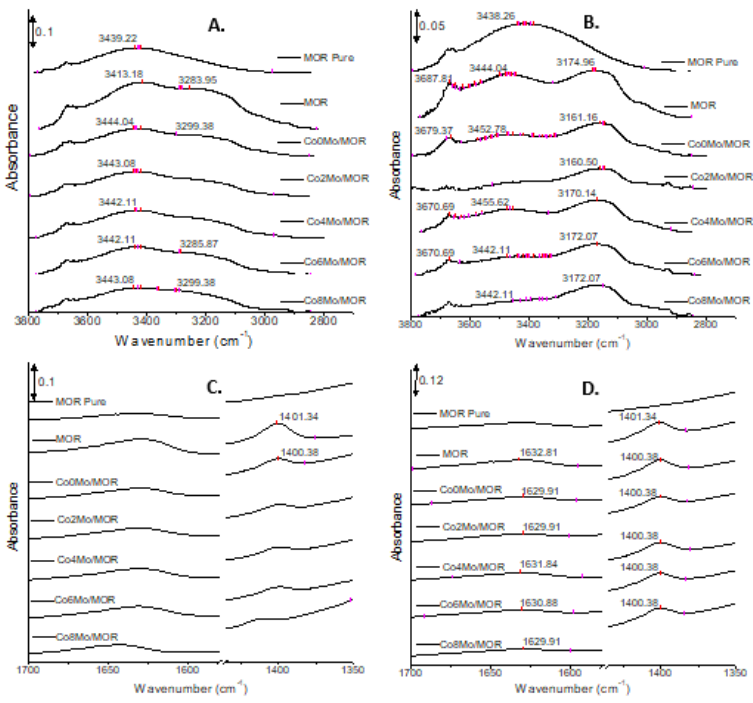
Figure 5: FTIR spectra of ammonia adsorption, (A) & (C) after evacuated at room temperature; (B) & (D) at 150oC.